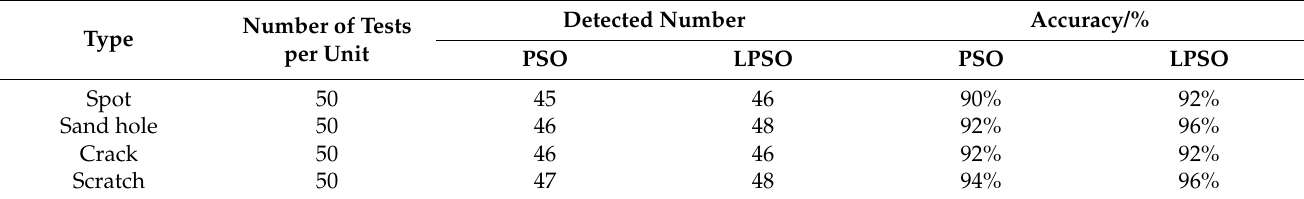
Table 6. The recognition accuracy of the log-Gabor feature extractions based on PSO and LPSO. Type